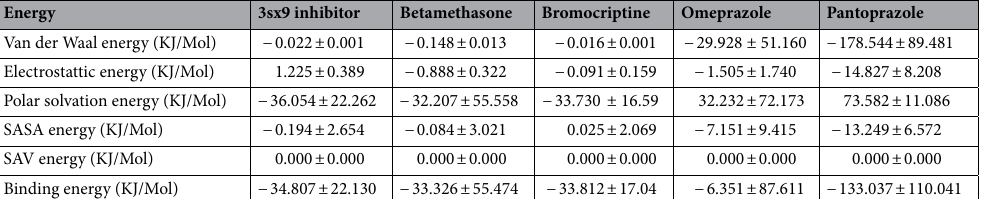
Table 6. The Van der Waals, electrostatic, polar solvation, SASA, SAV, and binding energies of the Omeprazole-CDPK1, Pantoprazole-CDPK1, Betamethasone-CDPK1, Bromocriptine-CDPK1complexes (kJ/ mol), calculated by the MMPBSA